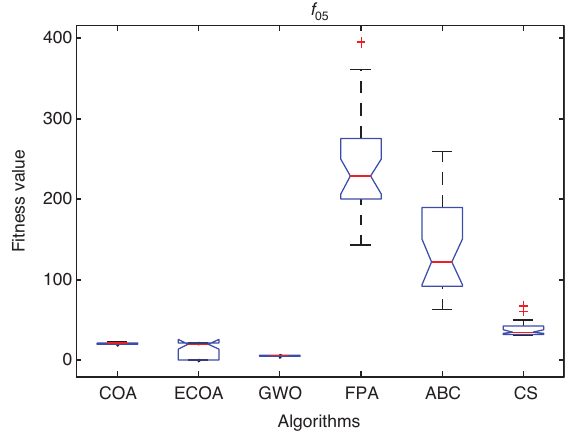
Figure 10: D = 30, ANOVA Test of Global Minimum for f